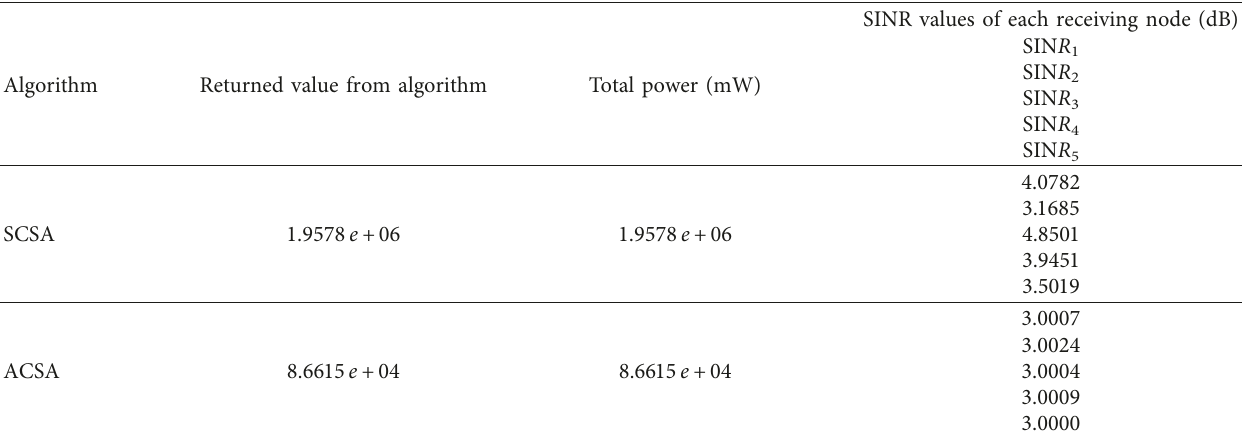
Table 11: Returned results of ACSA and other standard optimization algorithms for scenario